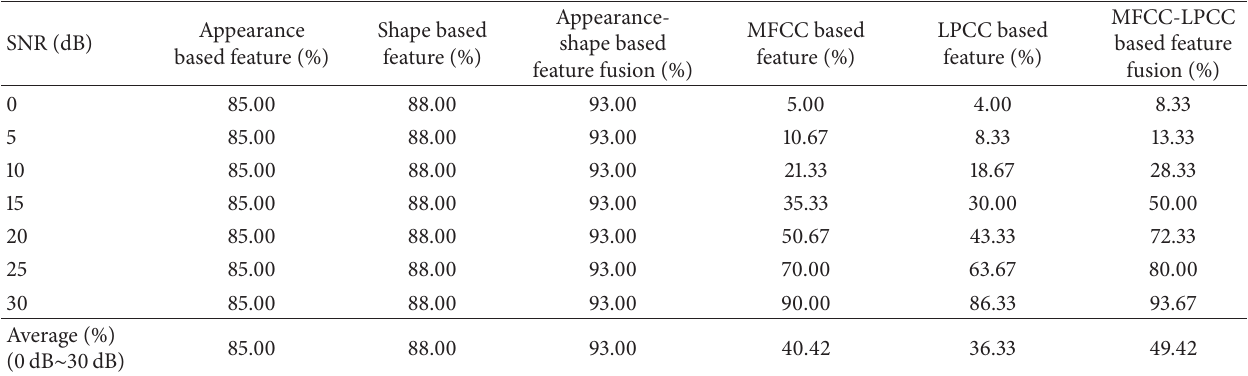
Figure 3: Results after setting up the number of hidden states of DHMM with various dimensions. Table 1: Performance measurements among various combinations of appearance based, shape based, and appearance-shape based visual features and MFCC based, LPCC based, and MFCC-LPCC based audio features according to various